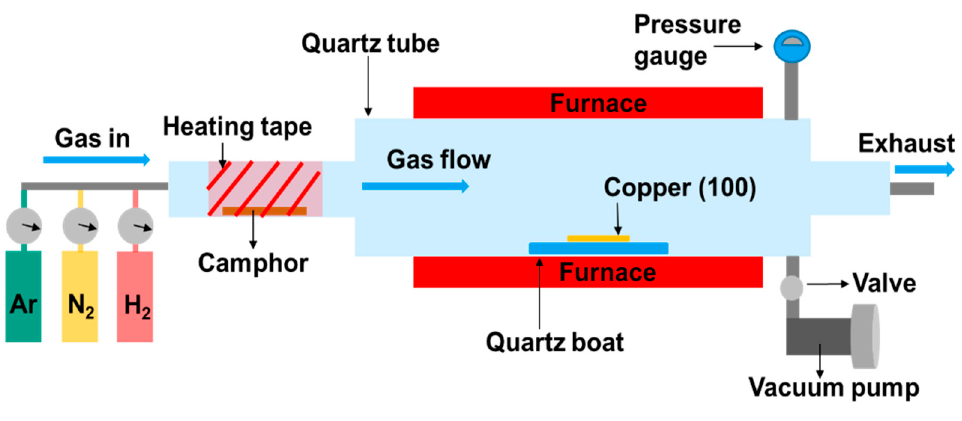
Figure 1. Schematic diagram of our atmospheric pressure chemical vapor deposition (APCVD) setup.